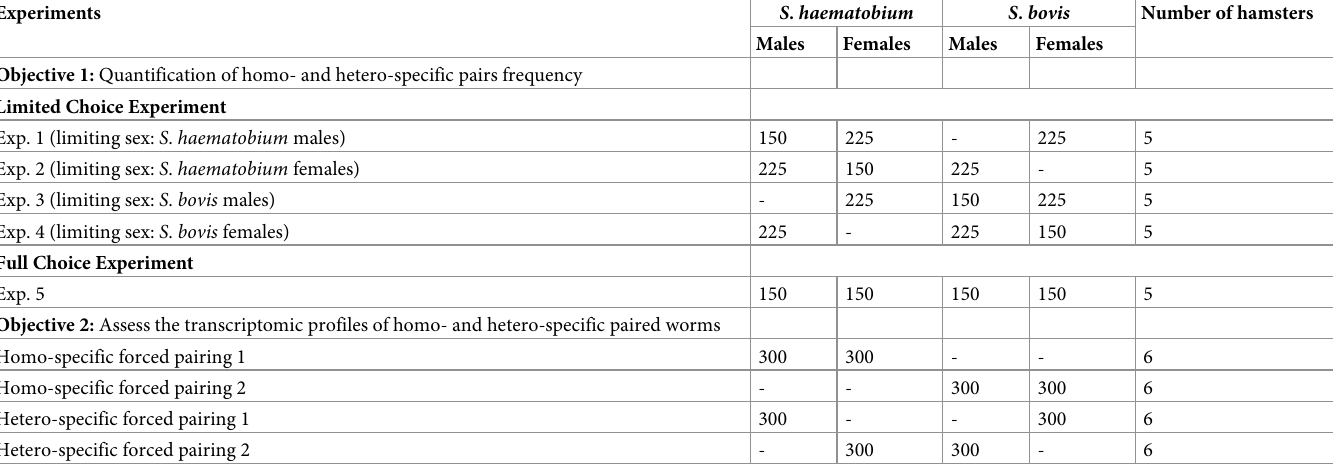
Table 1. Number of cercariae used for each experiment according to the species and the sex of the parasite.